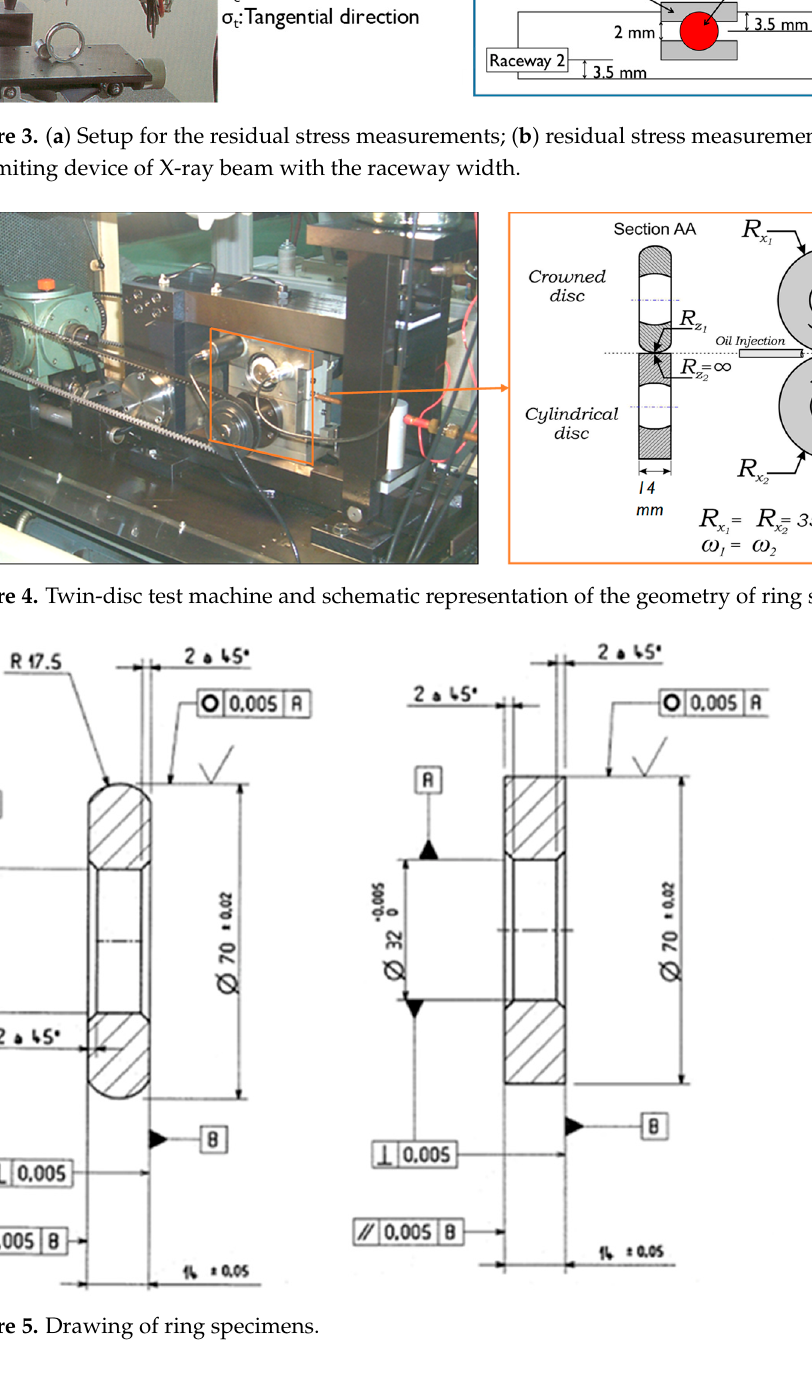
( c ) limiting device of X-ray beam with the raceway width.